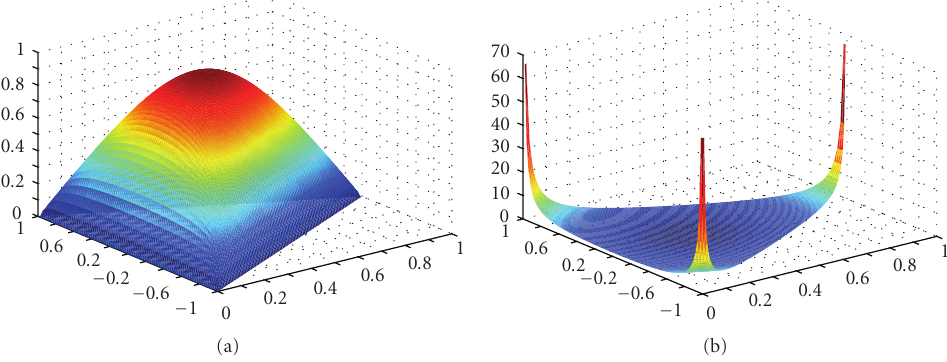
Figure 3: Shape functions for the scale-invariant equilateral (a) and local (b) models: S ( k 1 , k 2 , k 3 ) = S ( (cid:11) α , (cid:11) β ) on transverse slices with 2 (cid:11) k = k 1 + k 2 + k 3 = const . See main text for the definition of the coordinate reparametrization in terms of (cid:11) α ( y -axis) and (cid:11) β ( x -axis).